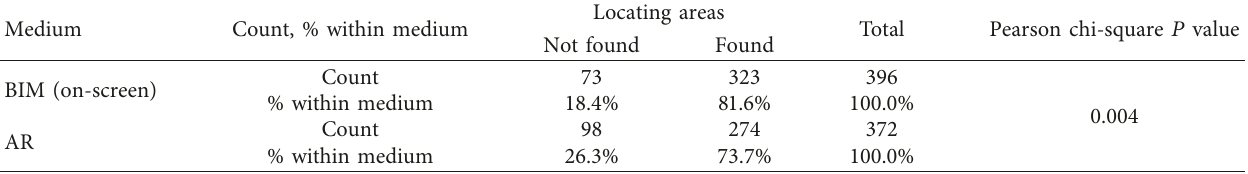
Table 5: Effect of visualization medium in locating areas and corresponding chi-square results.